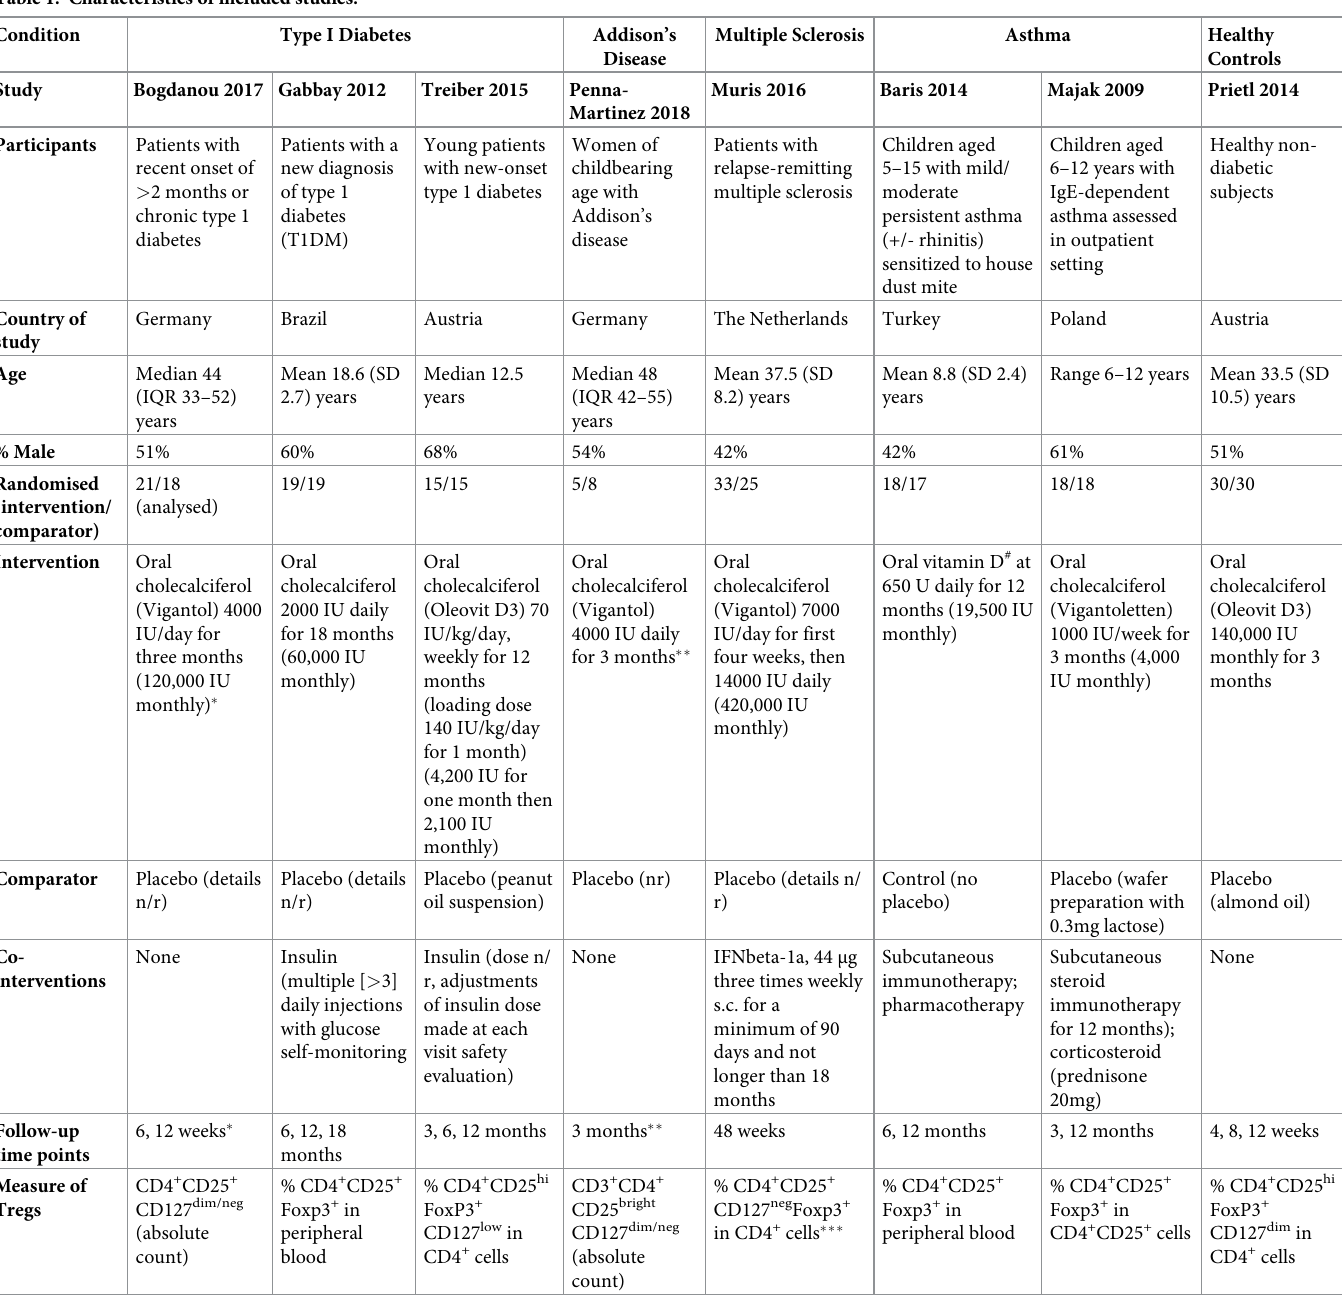
Table 1. Characteristics of included